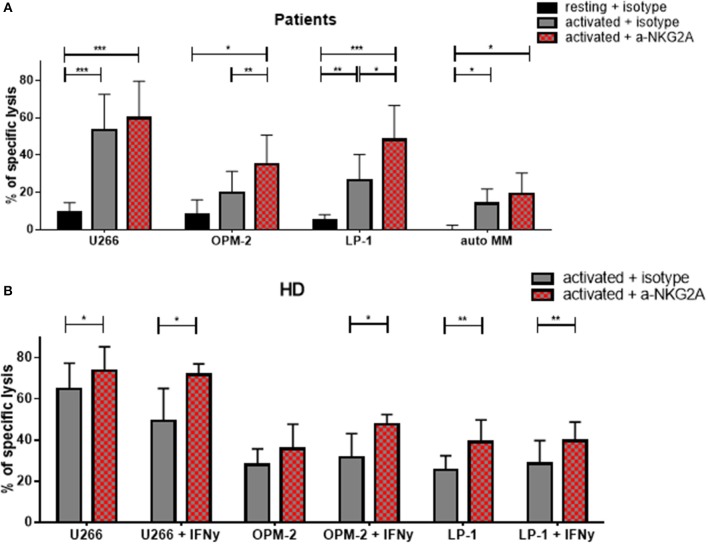
Functional blockade of NKG2A significantly increases NK cell cytotoxic potential. Isolated NK cells from (A) patients and (B) healthy donors were pre-activated by stimulating them with IL-2 and IL-15 for seven days and then co-cultured with different multiple myeloma cell lines, as well as, autologous, primary cells for 24 h. Prior to co-culture, the NK cells were treated with either an anti-NKG2A or isotype antibody to functionally block NKG2A on the NK cell surface. The percentage of dead tumor cells was determined with a live-dead stain (DAPI) via flow cytometry after 24 h of co-culture. NK cells and tumor cells were co-cultured with a 2:1 E-T ratio. For patient samples, 8 individual experiments for resting + isotype, 9 individual experiments for activated + isotype and activated + a-NKG2A were performed (n = 8–9). For healthy donor samples, 5 individual experiments were performed (n = 5). Statistical analysis with two-way ANOVA + Sidak's multiple comparison: *p < 0.05, **p < 0.01, ***p < 0.001, ****p < 0.0001.